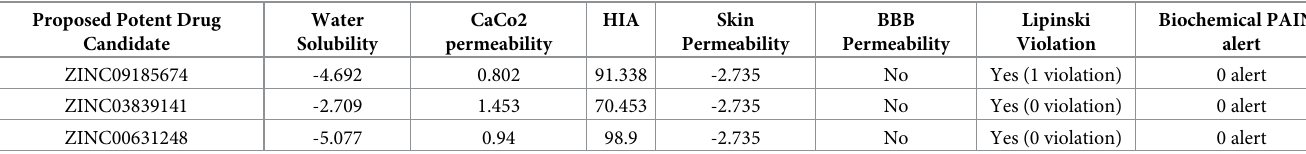
Table 5. ADMET Profiling: Properties analysis of shortlisted 3 compounds. Proposed Potent Drug